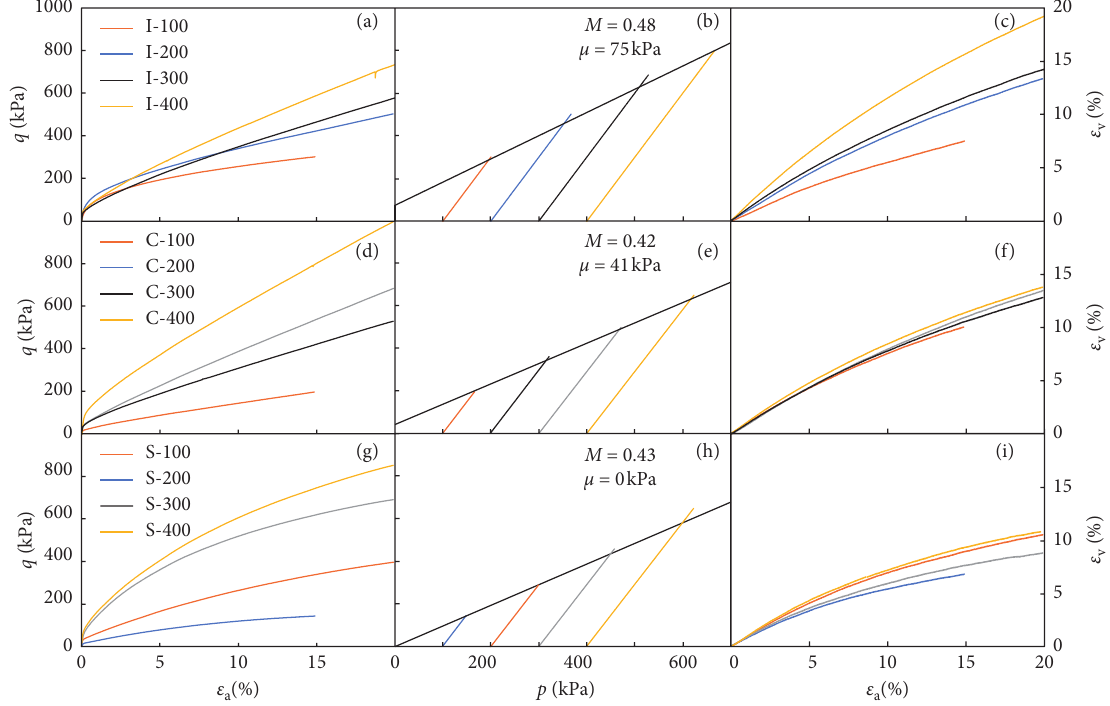
Figure 10: Results of triaxial drained tests on intact, compacted, and saturated loess specimens ( q is the deviator stress, kPa; p is the confining stress, kPa; ε a is the axial strain, %; ε v is the volumetric strain, %). Table 3: Parameters of the critical state. Loess 0 M and μ are the slope and intercept of the critical state line (CSL); φ and c are the effective internal friction angle and effective cohesion; σ 0 is the bonding